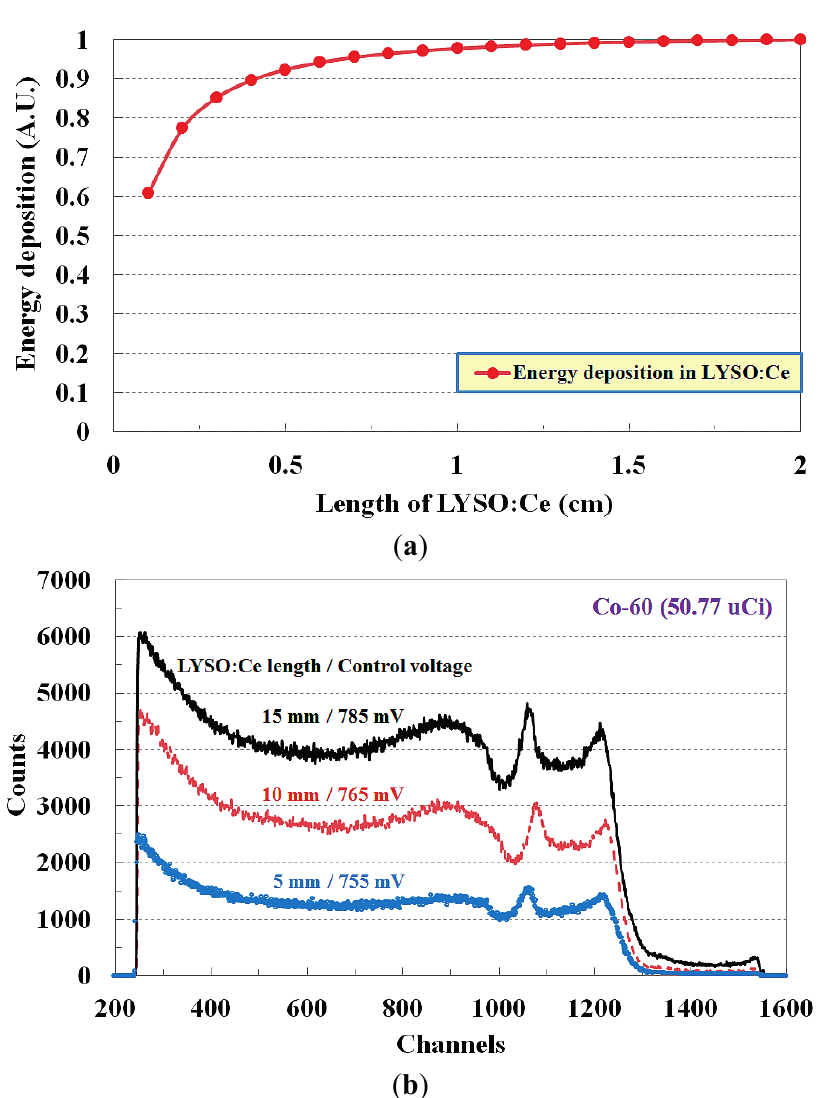
Figure 3. ( a ) Energy deposition of the electrons owing to the gamma-ray emitted from Co-60 according to the length of LYSO:Ce obtained by using a MCNPX simulation and ( b ) Variation of gamma-ray energy spectrum according to the length of